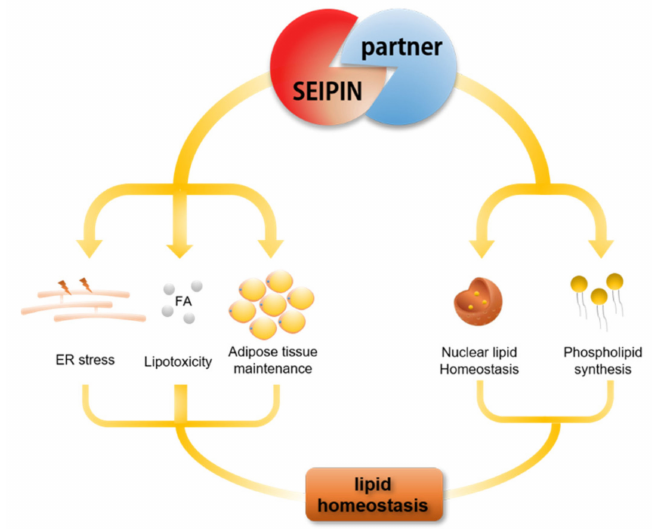
Figure 5. SEIPIN and partner proteins (that interact with SEIPIN) play an important role in cell lipid